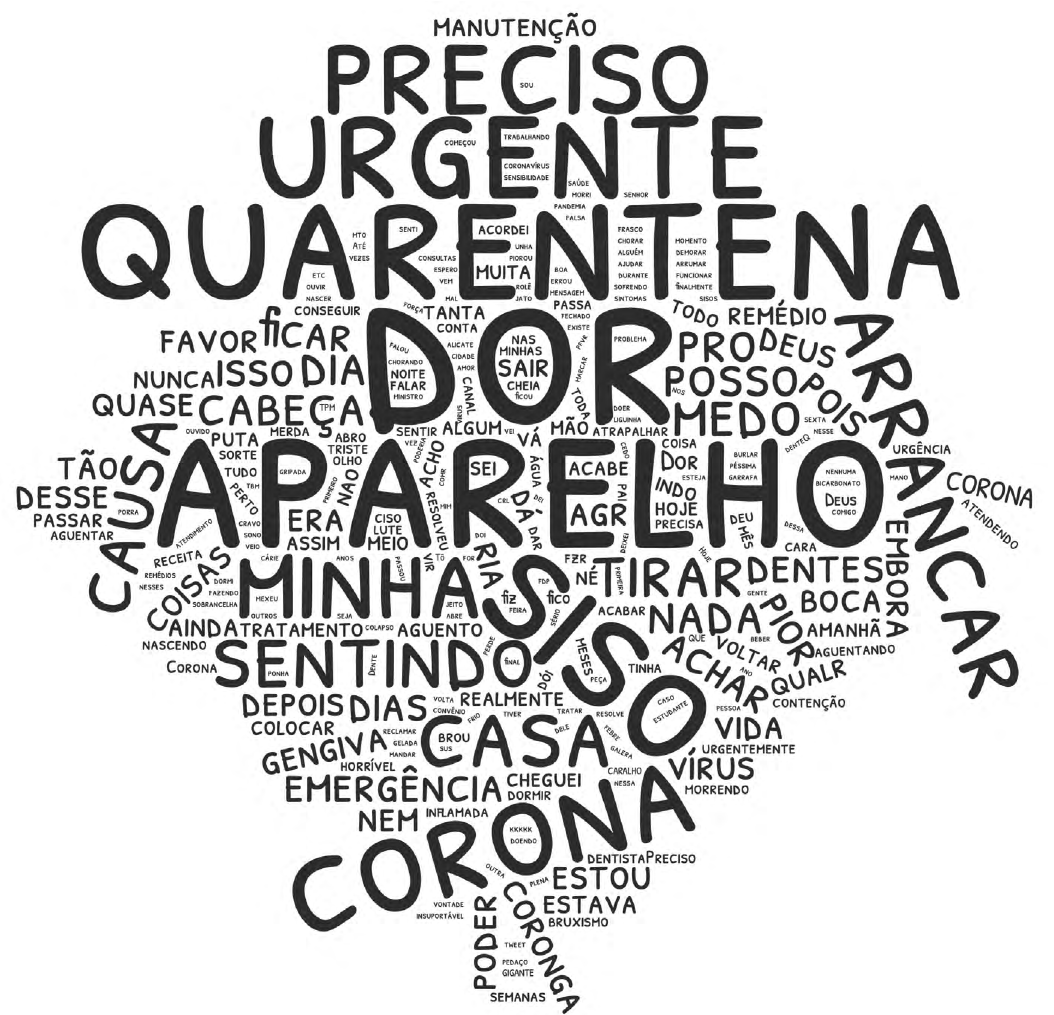
Figure 1. Word cloud created according to the searches with predefined terms. Font size correlates with the greater frequency of the word used in tweets related to self-reported dental treatment